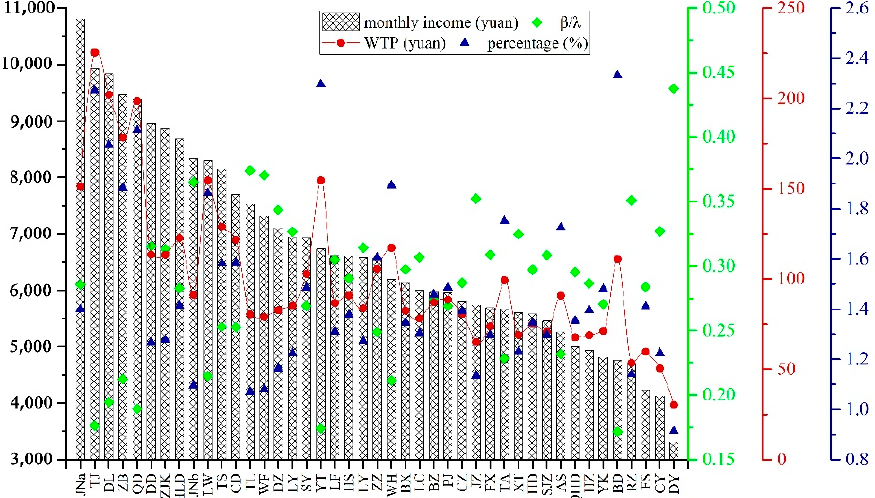
Figure 3. Willingness to pay and its proportion of monthly income from Bohai Rim Area urban residents. Those regions are coded by abbreviation as follows: JN a —Jinan, TJ—Tianjin, DL—Dalian,